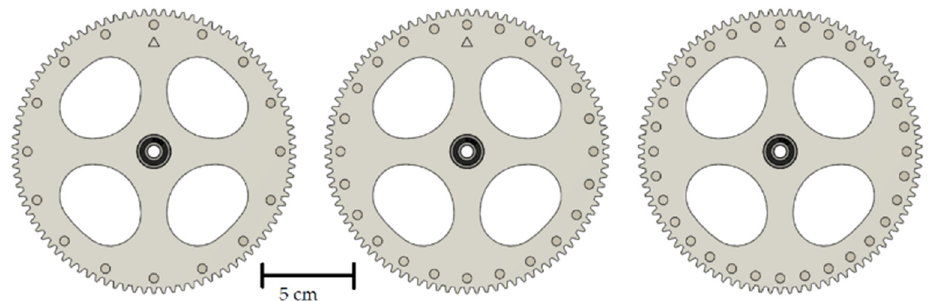
Figure 3. Gears with 16, 24 and 32 magnets (from top to bottom).